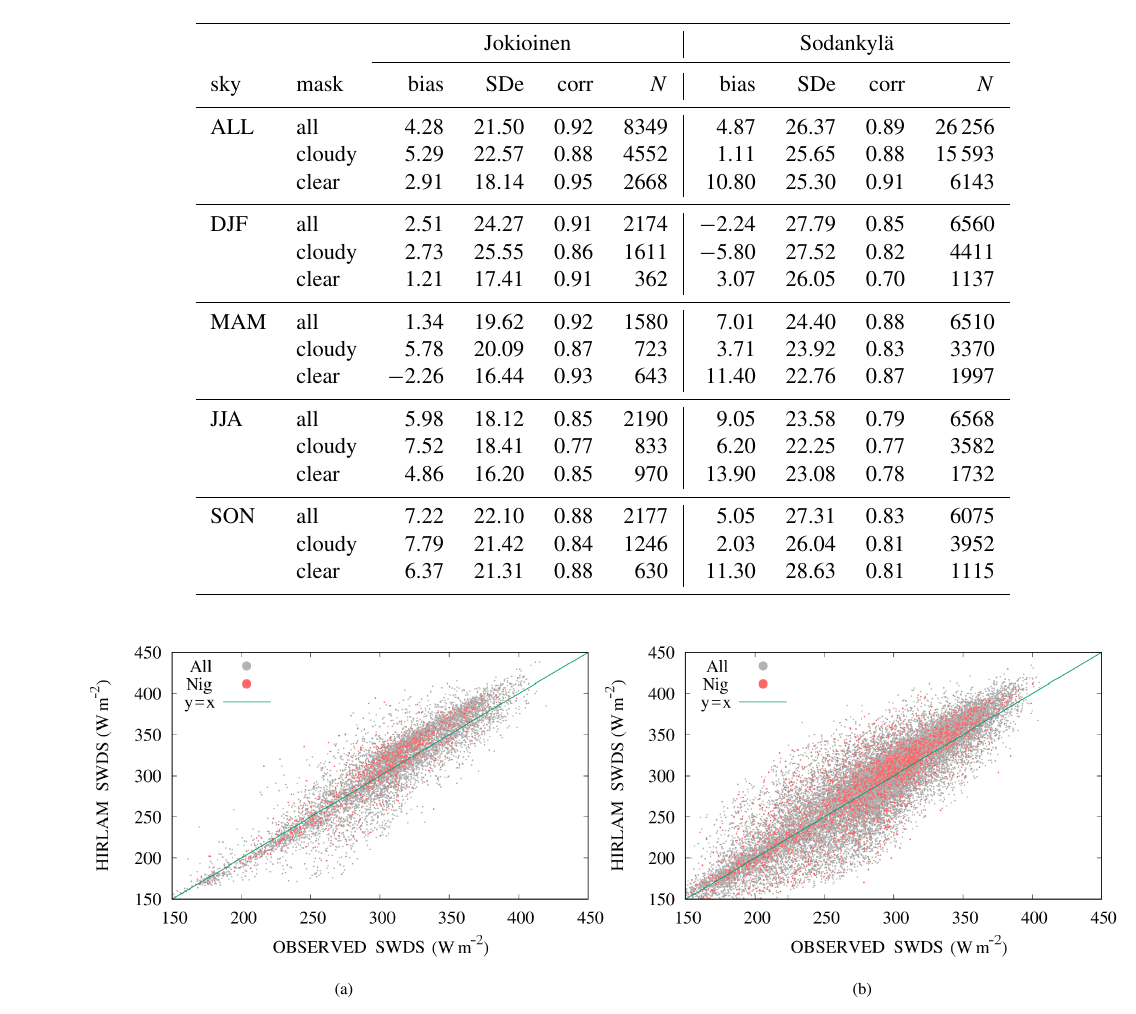
Table 5. As in Table 3 but for LWDS. In Jokioinen, LW observations represent the period from May 2013 to March 2016, at Sodankylä, from April 2006 to March 2016.